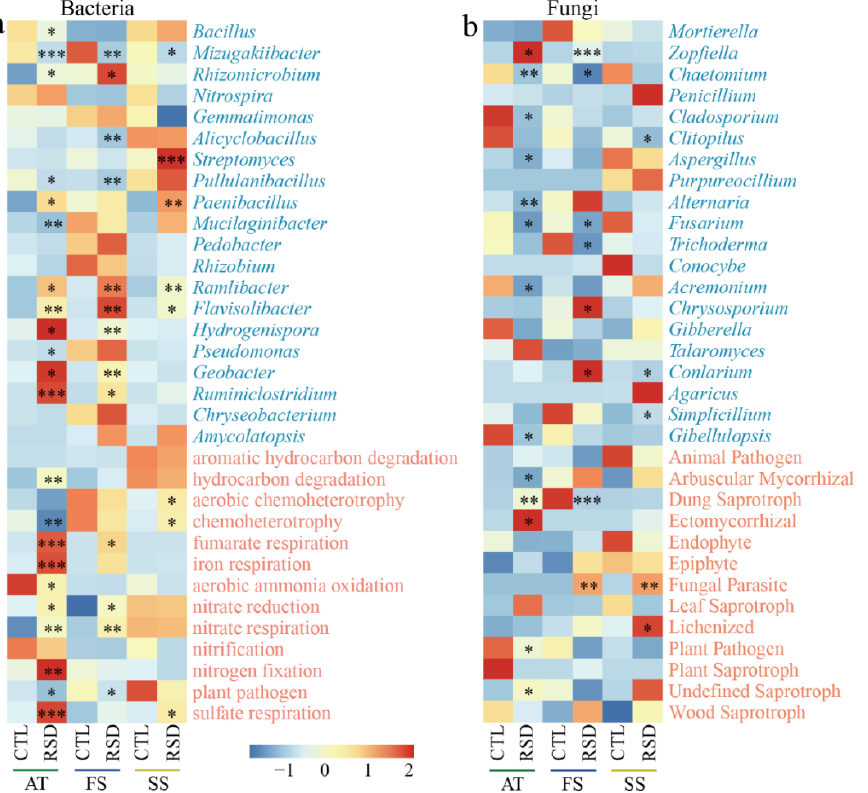
Figure 4. Heatmap displaying the relative abundances of top 20 dominant genera and functional groups in bacteria ( a ) and fungi ( b ). * ( p < 0.05), ** ( p < 0.01), and *** ( p < 0.001) represent significant differences between CTL and RSD in different time points according to independent-samples t -test. CTL, untreated soil; RSD, soil incorporated with molasses, irrigated to saturation, and covered with plastic film. AT, FS, and SS indicate the soils collected from after treatment, the first season, and the second season, respectively.